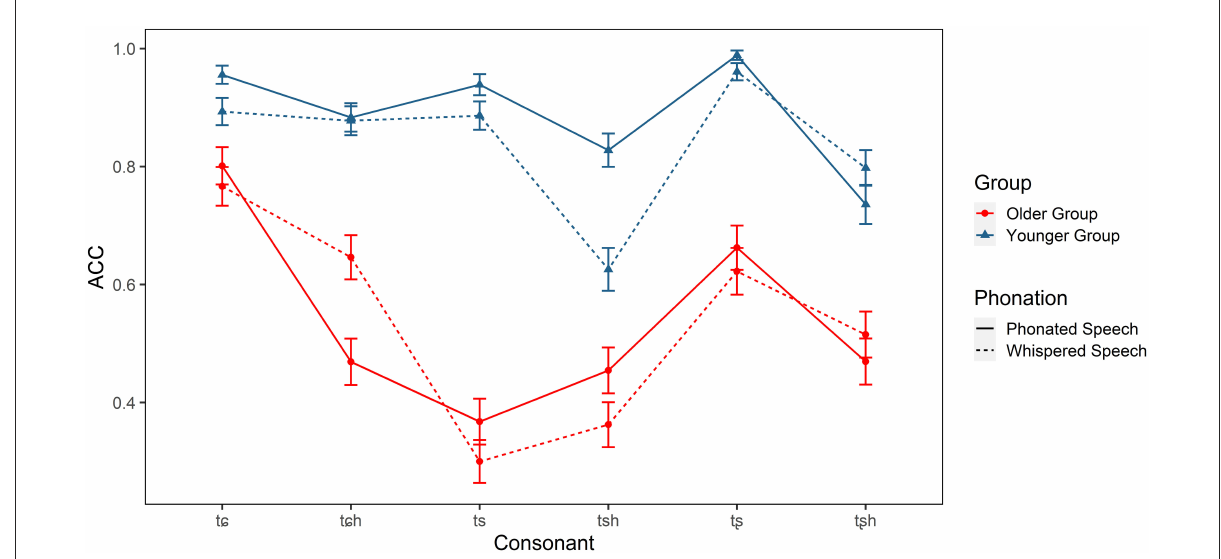
FIGURE5 Identification accuracy of the Mandarin affricates (/t C , t C h , ts, ts h , t ù , t ù h /) in older and younger listeners.